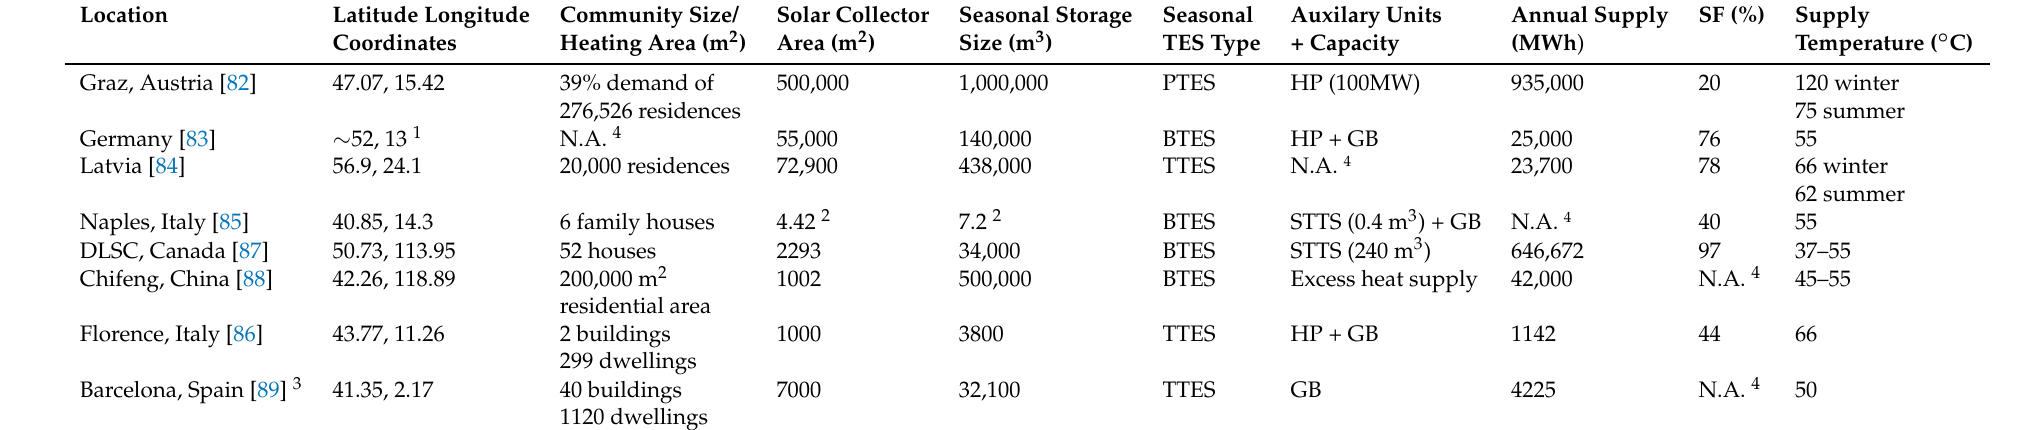
Table 4. Key technical information of some CSHPSS systems